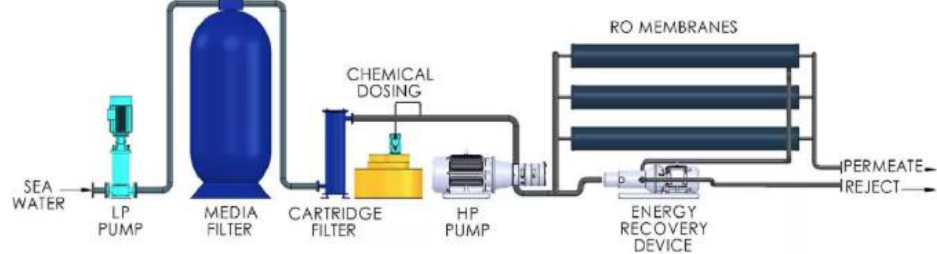
Figure 8. Schematic diagram of the main components of the proposed seawater desalination plant.